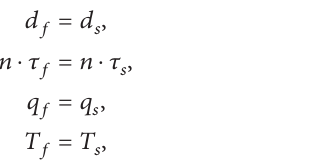
this boundary or interface. Deformation compatibility